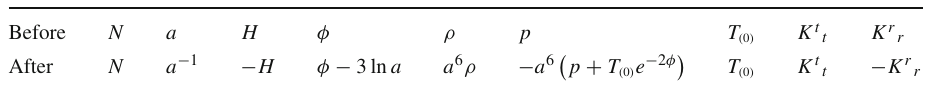
Table 1 Cosmological T-duality transformations ( h = k = 0 )